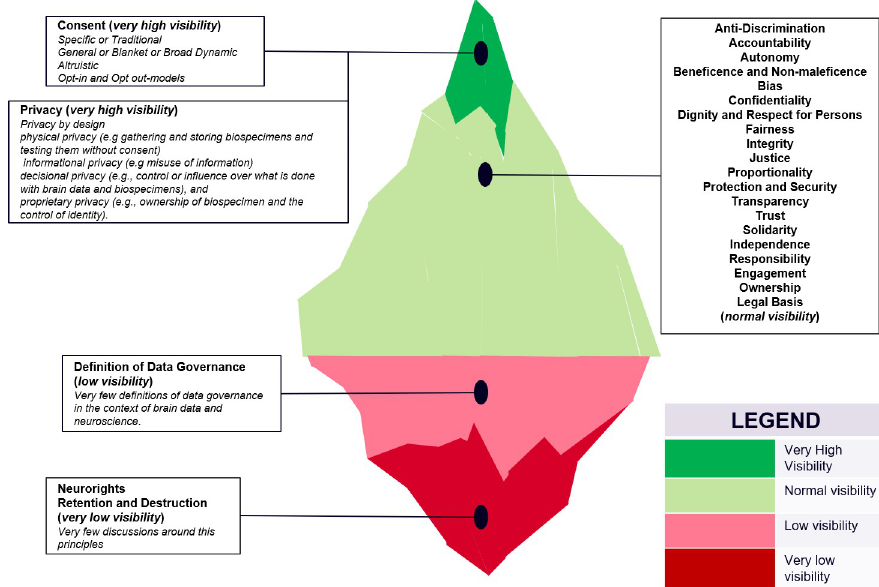
Fig 2. Data governance, ethical and legal principles